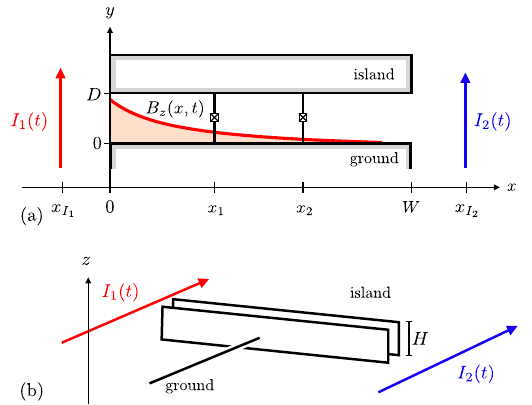
effects in the main text, such as negative capacitances, or time- dependent capacitances. a Top view of the SQUID circuit. The ground and island form a parallel plate capacitor with distance D ( y - direction) and width W ≫ D ( x -direction). Two current wire sources I 1 (red) and I 2 (blue) produce magnetic fi elds. We indicate the spatial distribution of the fi eld for the fi rst source (red curve).